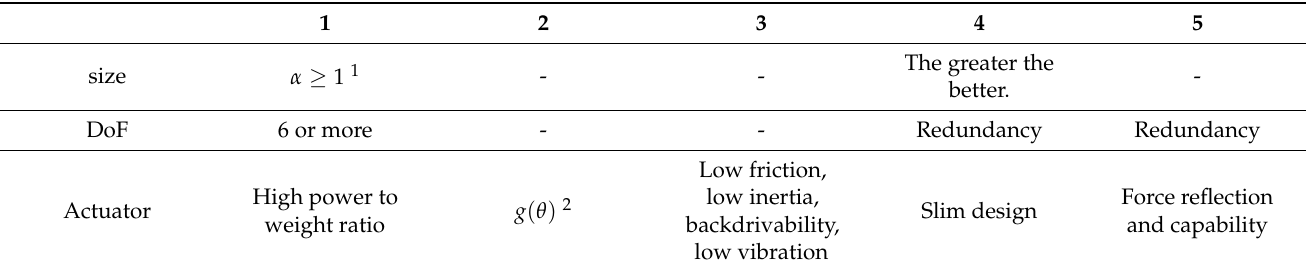
Table 1. Design table of K-handler requirements.